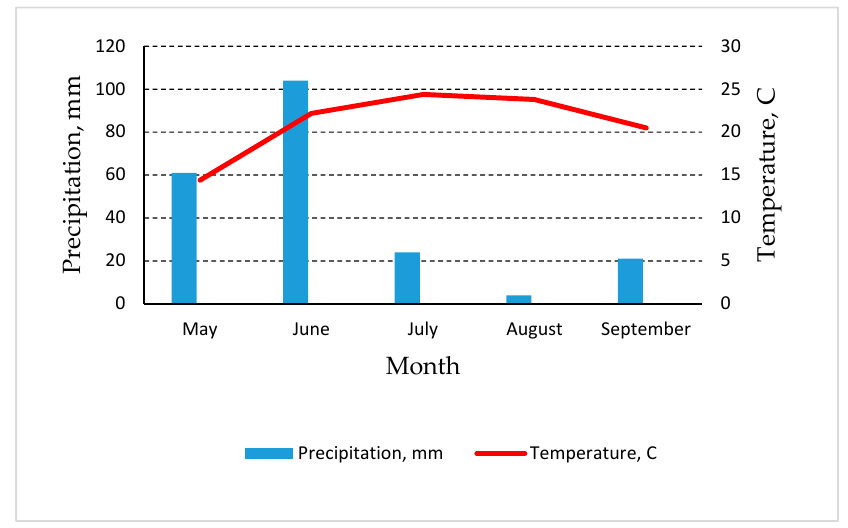
Figure 6. Monthly air temperature and precipitation during the sweet sorghum growing. Yield depends on several factors, including precipitation. Water productivity of selected crops is presented in Table 6 [76]. Maize has better water productivity compared to other crops. Sorghum holds a second position. However, on dryland sweet sorghum has almost the same indicator. Taking into account the water productivity of sorghum, it can be predicted that under favorable weather conditions, a yield of sweet sorghum may be increased by 0.5–2.1 t/ha.